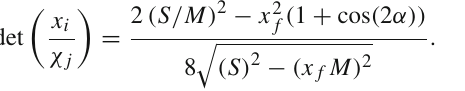
Fig. 3 Left: Relativistic PI in two dimensions for paths with the same action S , where the red curve represents all equivalent points x 1 for a given action value S > S cl . Right: It is interesting to note that in the classical limit, when S → S cl , the elliptic contour of equivalent points x 1 collapses to the classical path. This means that the two local symmetries ( b ) and ( c ) are indistinguishable at the classical level